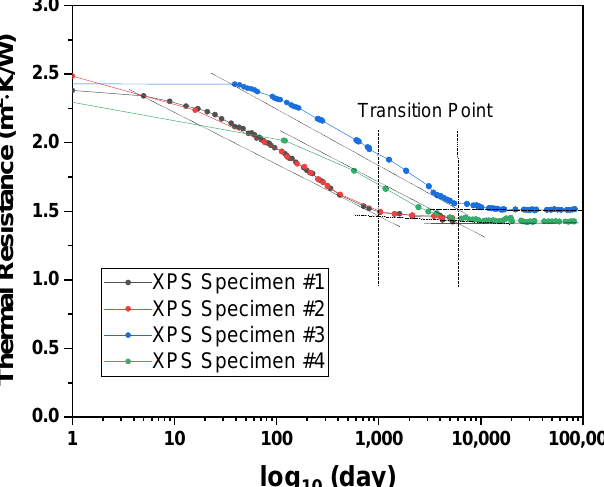
Figure 9. Comparison of measurement results on converting them to results for a thickness of 50 mm.